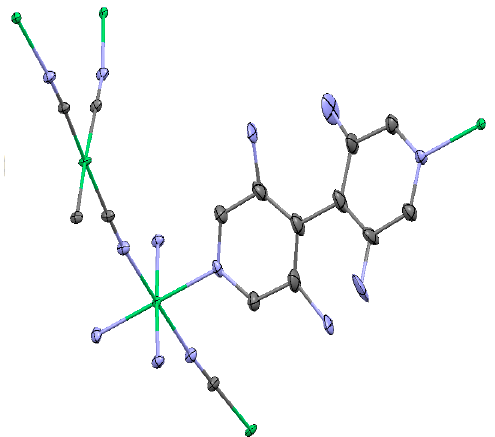
Figure 13. The basic motif of the Ni(BpyNH2)[Ni(CN) 4 ] molecules (C-grey, N-blue, Ni-green; probability ellipsoids drawn at 50%).